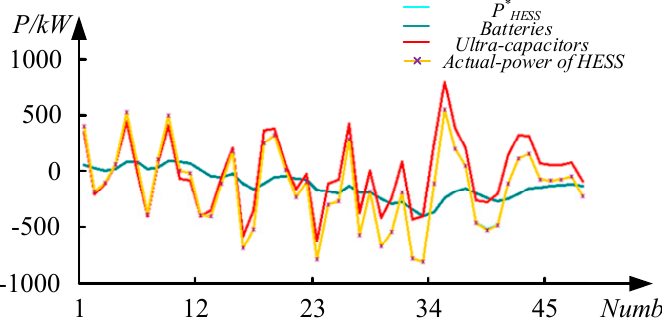
Figure 7. P ∗ HESS and actual HESS power for sample points 1–48.